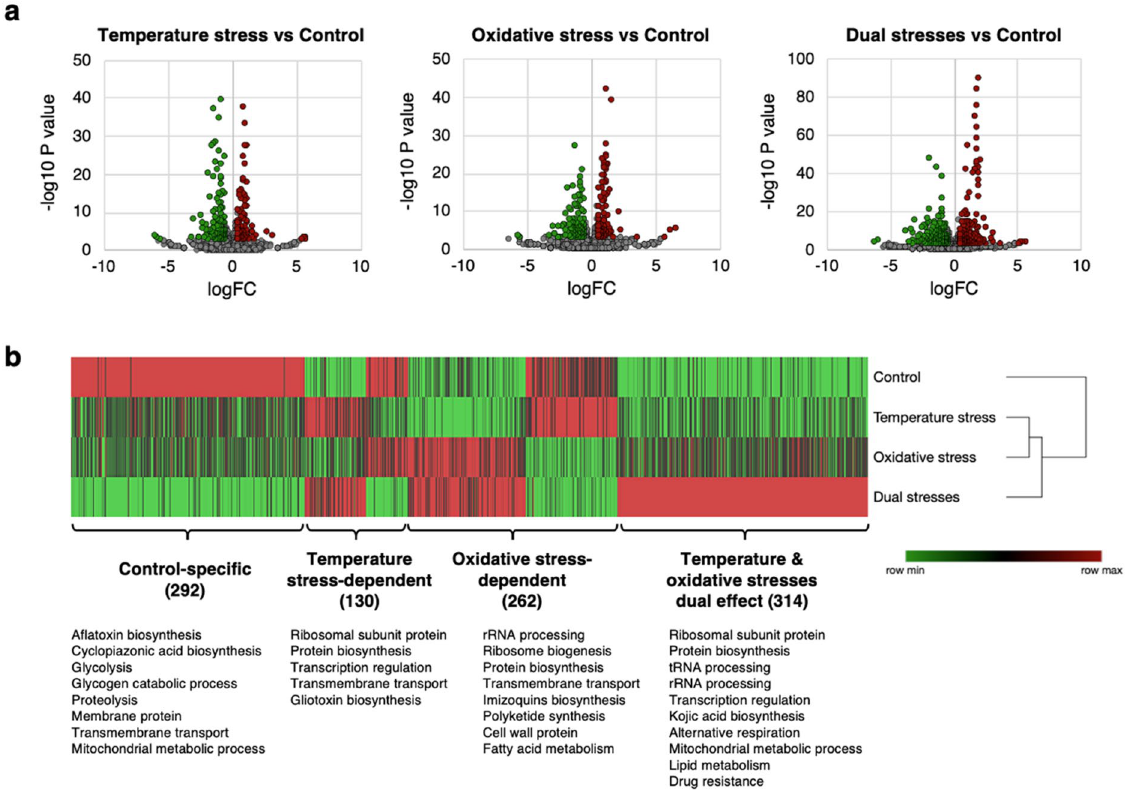
Figure 3. Differential gene expression analysis. ( a ) Volcano plot of detected genes indicating DEGs under different stress conditions that were significantly upregulated (red circle), significantly downregulated (green circle), or nonsignificant (grey circle) (False Discovery Rate (FDR) < 0.05). ( b ) Heatmap indicates relative expression of DEGs that specifically responded to temperature stress, oxidative stress, and the dual stresses treatment. DEGs that exhibited significantly higher expression levels under control condition than under stress conditions are described as “Control-specific”. Genes that were differentially expressed under temperature stress but not under oxidative stress are described as “Temperature stress-dependent”. Genes expressed differentially under oxidative stress but not under temperature stress are described as “Oxidative stress-dependent”. Genes that exhibited significantly higher expression levels under the dual stresses treatment are labelled “Temperature & oxidative stresses dual effect”. The number of DEGs included in each of these categories is indicated. The biological functions (containing 2 to 39 DEGs) represented in each category are listed below their respective category